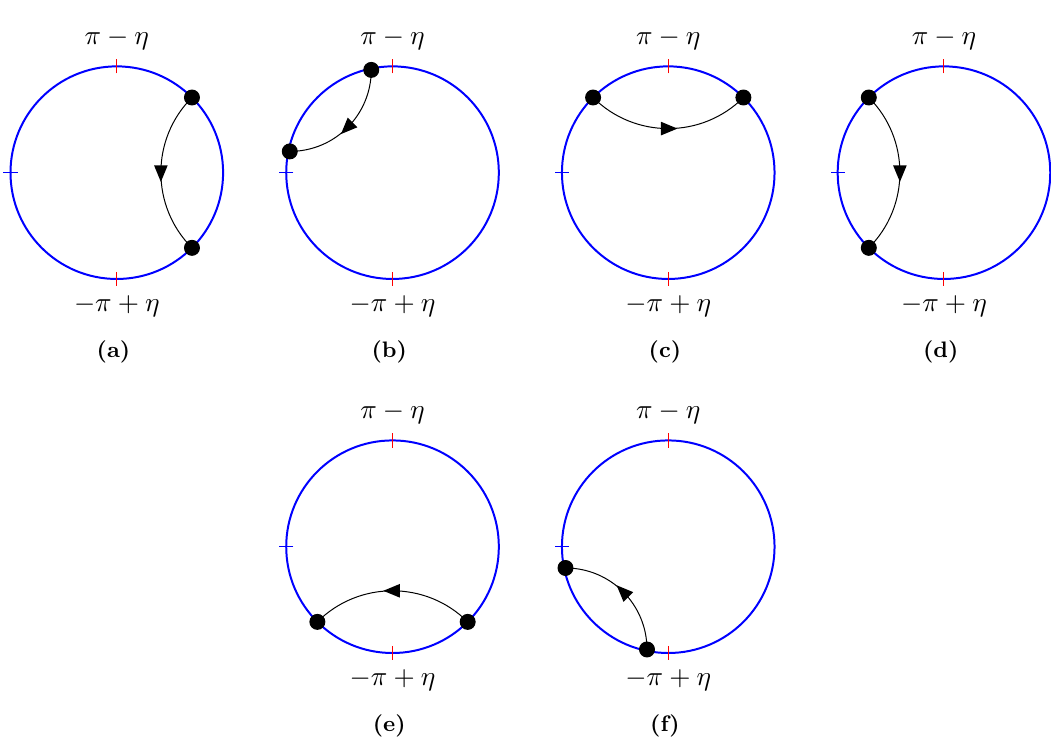
Figure 5. One-loop diagrams for the cut-off Wilson